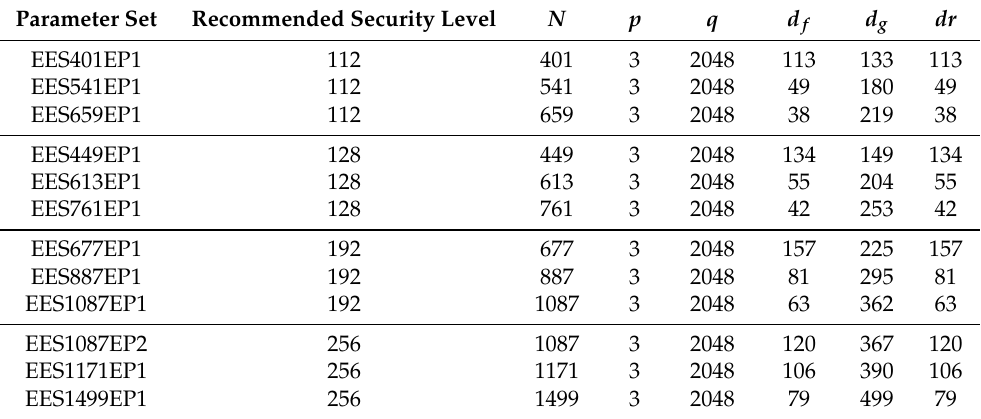
Table 1. Parameter sets for